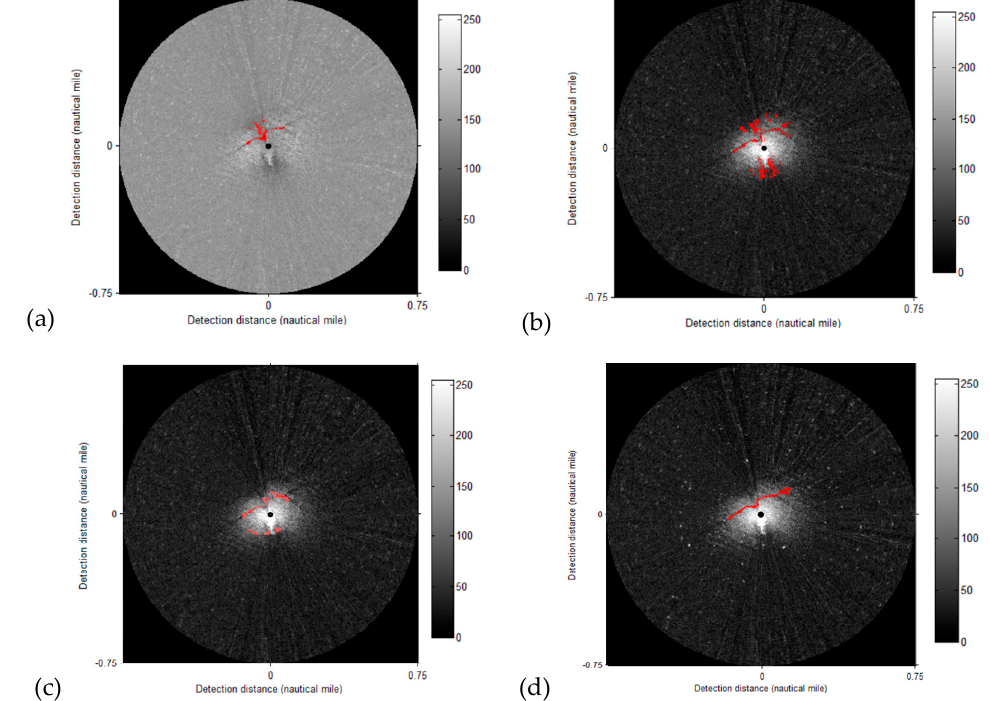
Figure 22. Comparison of segmentation results with different methods: ( a – d ) Results from the methods proposed by Zhu et al. [24], Liu et al. [25], Xu et al. [26], and our method, respectively.